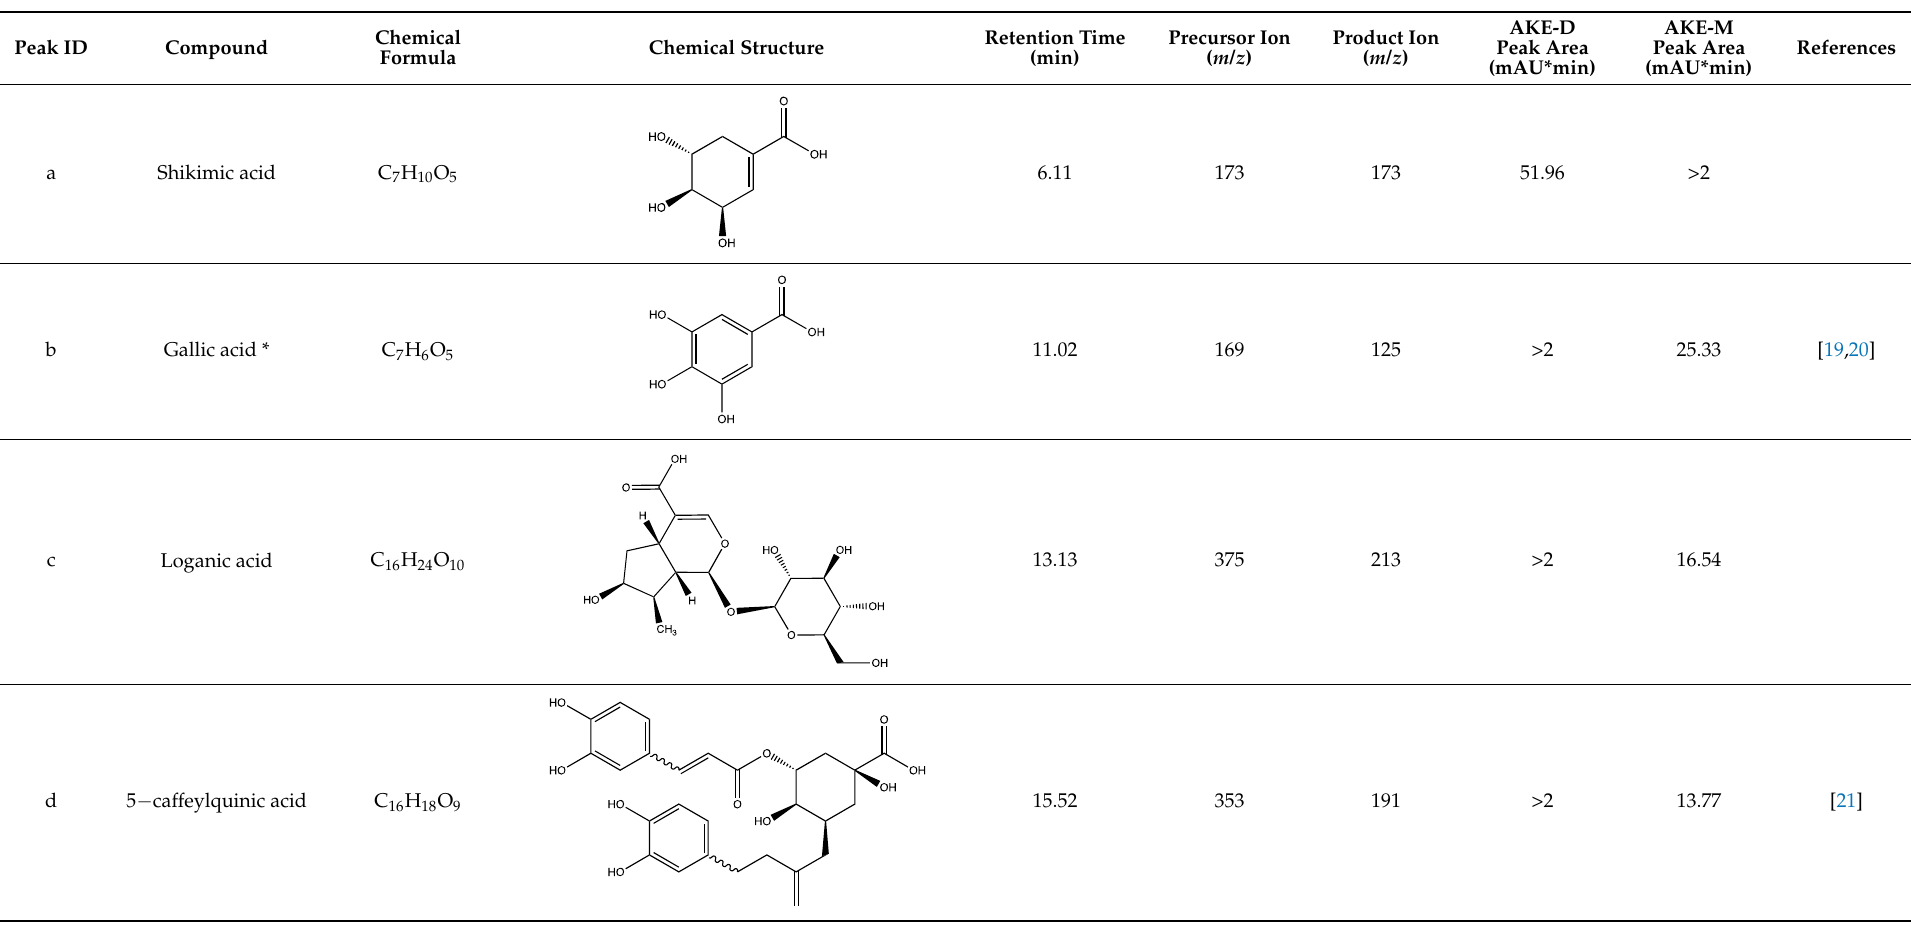
Table 1. Compounds detected in the decoction (AKE(D) and maceration (AKE(M) extract obtained upon chromatographic analysis. Retention time, parent and product ion m / z values, and peak areas for both extracts are indicated. n.d.: not detected. * compounds identified with the internal standard.